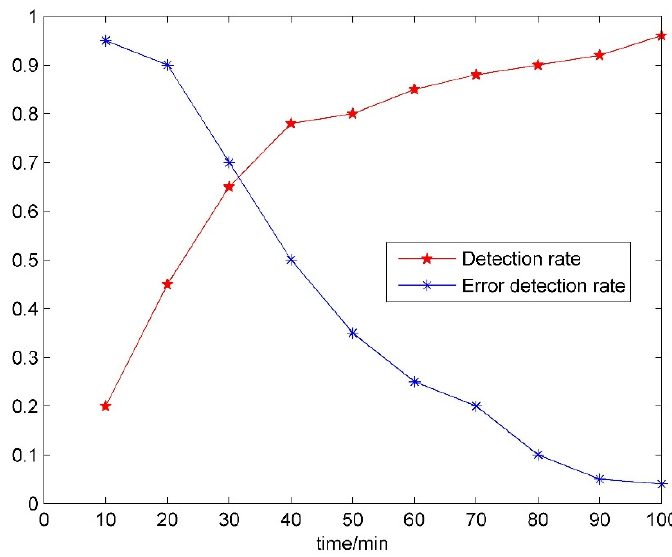
Figure 10. Accuracy and false detection rate.